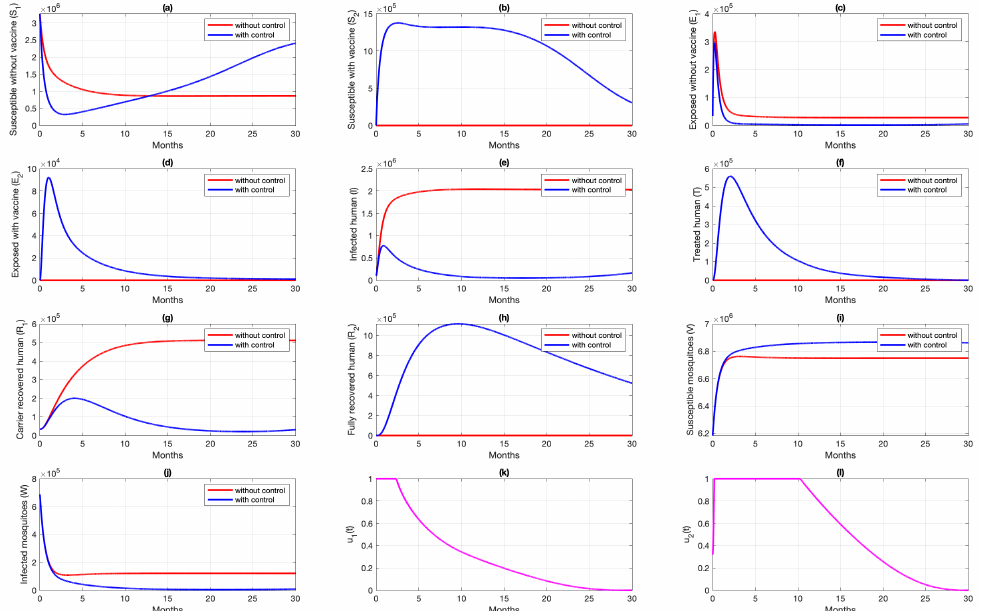
Figure 10. Dynamics of human ( a – h ), mosquitoes ( i , j ), and controls ( k , l ) under the scenario of both intervention applies. Red and blue curve present a condition of without and with implementation of control.